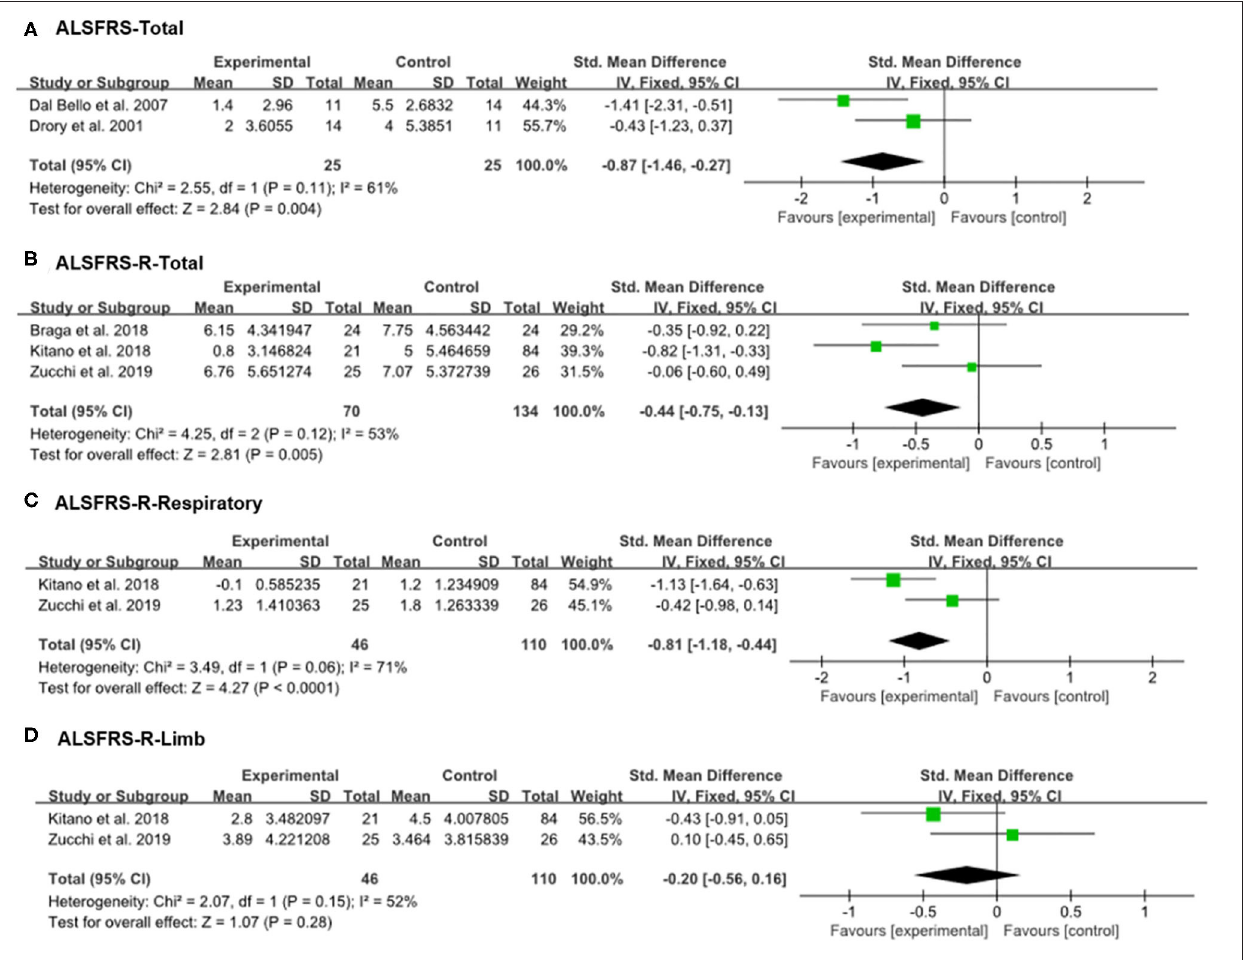
FIGURE 3 | Forest plot of 6-month outcomes. (A) Amyotrophic lateral sclerosis functional rating scale (ALSFRS)-Total, (B) ALSFRS-R-Total, (C) ALSFRS-R-Respiratory, (D) ALSFRS-R-Limb.